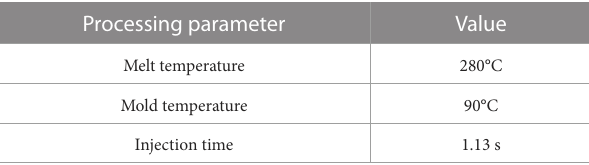
TABLE1 ProcessingconditionsoftheVenturitube. Processing